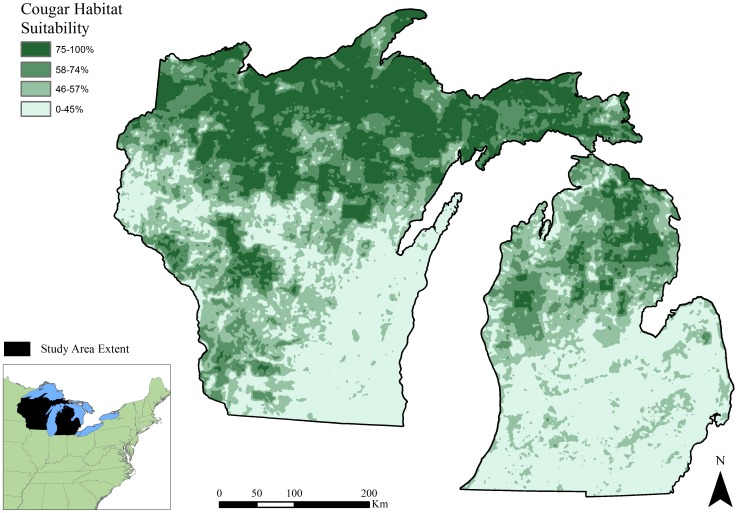
Cougar habitat rankings in the Upper Great Lakes region, USA.The cougar habitat model was generated based on expert-assisted variables and weights from LaRue [20], and LaRue and Nielsen [16], [26].